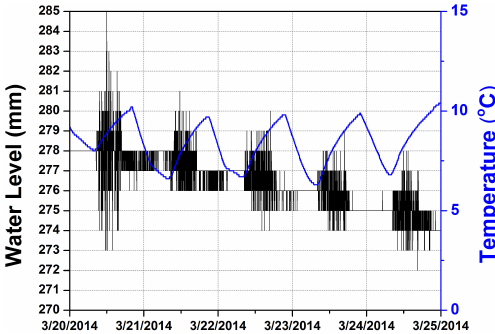
Figure 8. Water level and temperature readings during a 5-day pe- riod at the Alsea site on Oregon Highway